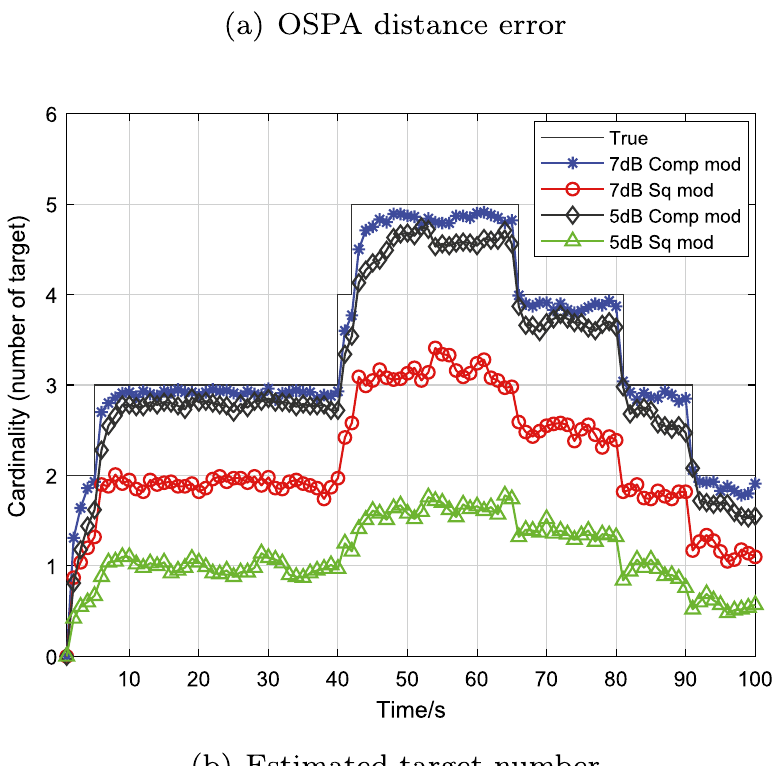
Fig. 11 Two likelihood ratio algorithms with different SNR ratios under Swerling